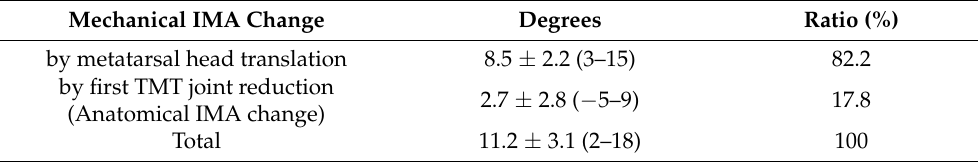
Table 3. Contribution ratio of angular changes in mechanical and anatomical intermetatarsal